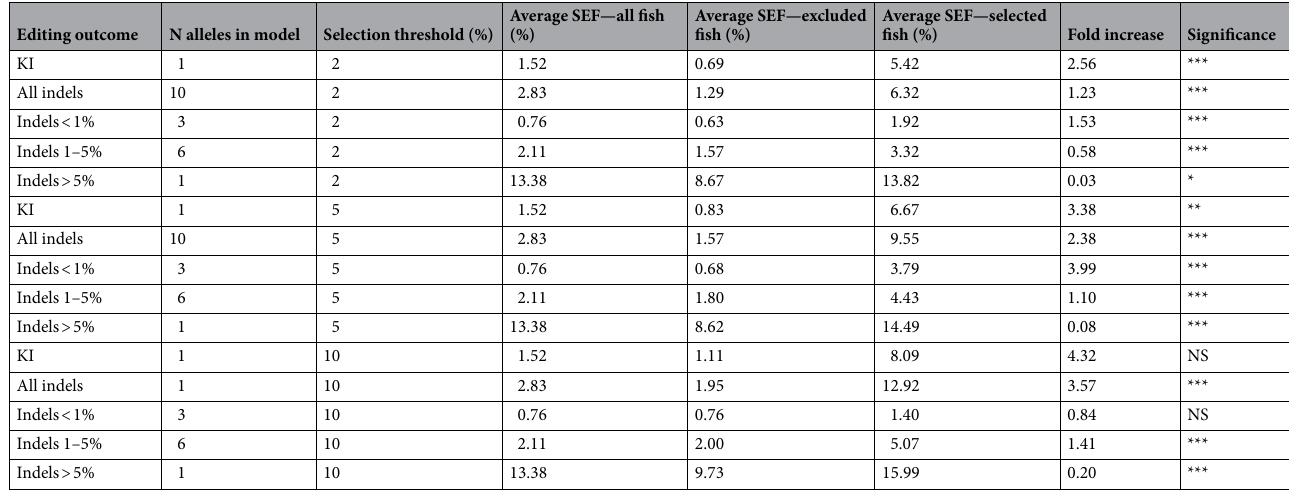
Table 1. Zebrafish embryo genotyper-based embryo selection at the LQTS locus (n = 51 fish for KI and n = 127 fish for indels). KI knock-in, indel insertion/deletion, SEF somatic editing frequency (according to whole